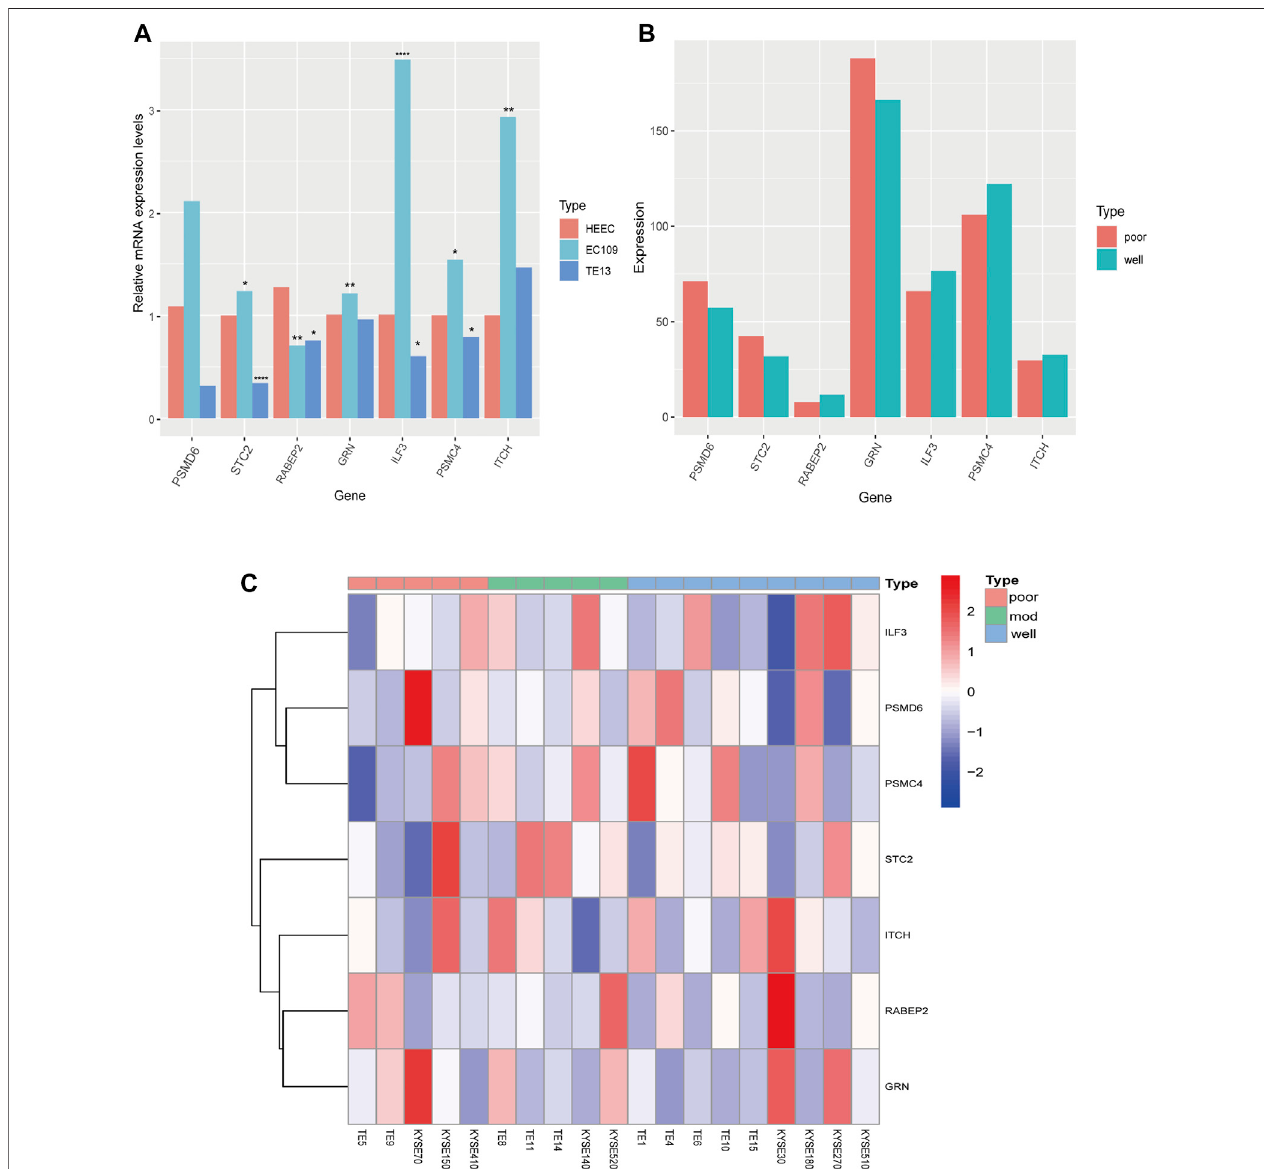
FIGURE 9 | The expression of seven prognostic genes in HEEC and ESCC cell lines. (A) The relative mRNA expression levels of seven prognostic genes in HEEC and two ESCC cell lines (EC109, TE13) by qRT-PCR. (B) The expression levels of seven prognostic genes in poorly differentiated and well differentiated ESCC cell lines. (C) The heatmap of seven prognostic genes expression in 19 ESCC cell